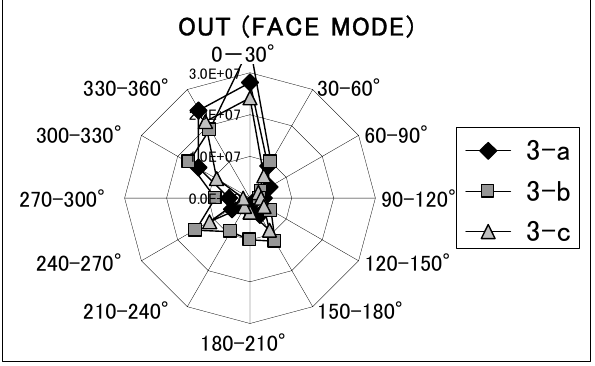
Fig. 14 Distributions of the interval RMS value of static pressure fluctuation (at the middle of blade, FOOT MODE). The unit is [mV/s 2 ].